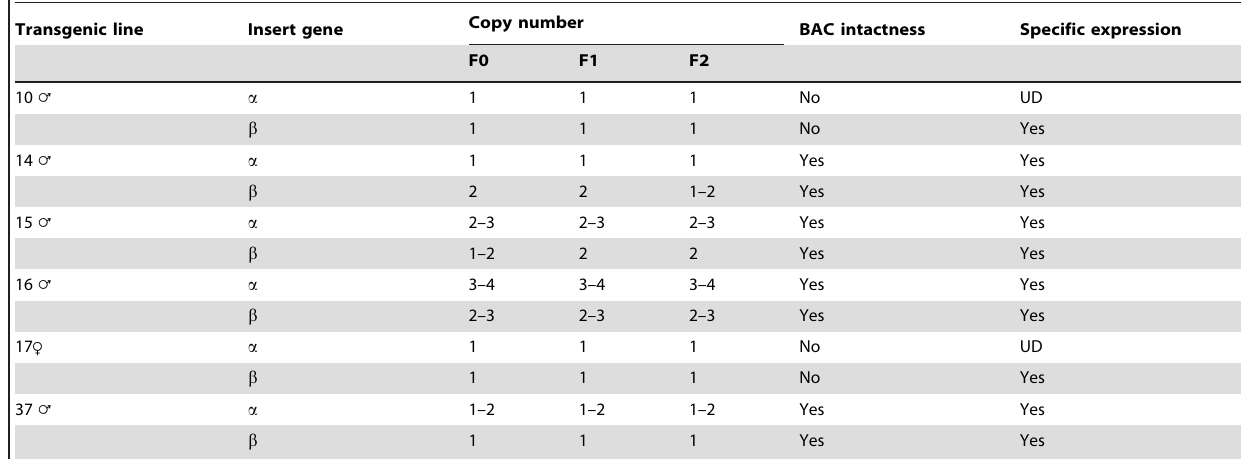
Table 1. Summary of BAC TG lines.